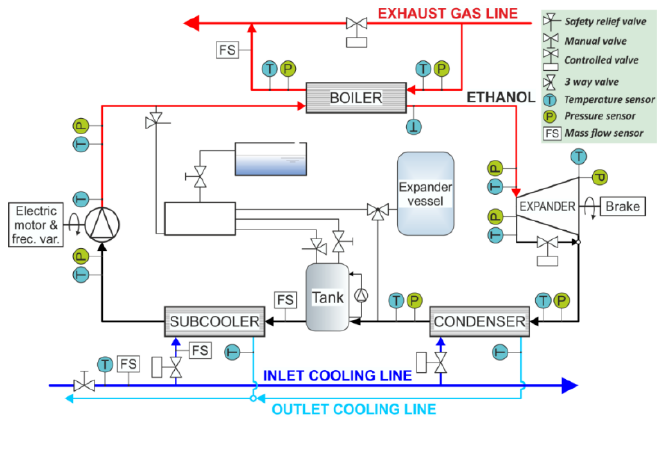
Figure 2. ORC scheme.